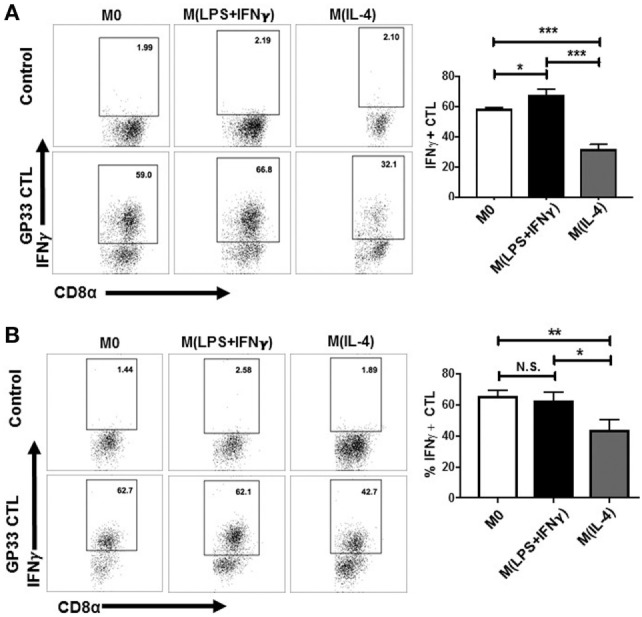
CD8+ T cells expanded by M(IL-4) stimulators exhibiting attenuated IFN-γ secretion. Sp-MΦ [M0, M(LPS + IFN-γ) or M(IL-4) cells] were pulsed with LCMV GP33-41 and cultured with CFSE-labeled splenocytes from LCMV immune mice (10:1 ratio) for 6 days in the presence of 5 U/mL IL-2 (A) or 10 U/mL IL-2 (B). Expanded cells were restimulated with GP33-41 pulsed BMA or unpulsed controls for detection of IFN-γ production by ICS in a restimulation assay to detect their epitope-specific activation. Graphs show mean ± SD from three replicates where *P < 0.05 and ***P < 0.0005. CFSE, carboxyfluorescein succinimidyl ester; LCMV, lymphocytic choriomeningitis virus infection.